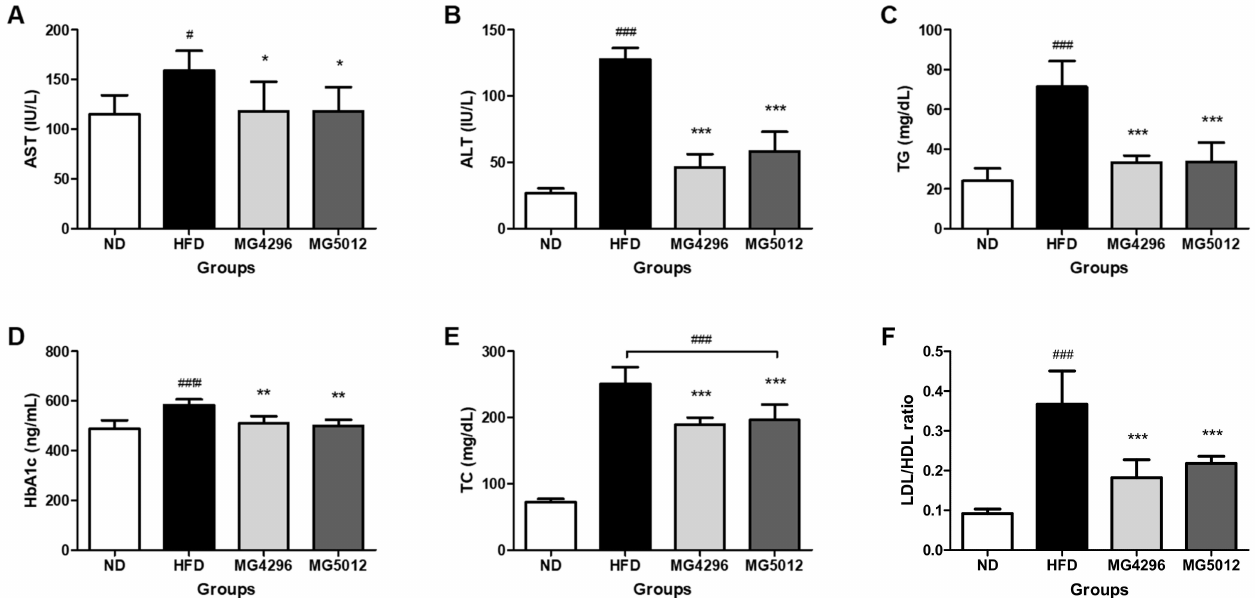
Figure 4. Biochemical profile of serum in HFD-induced T2DM mice. ( A ) AST, ( B ) ALT, ( C ) TG, ( D ) HbA1c, ( E ) TC, and ( F ) LDL/HDL ratio. Data are presented as mean ± SD ( n = 6). # p < 0.05, ### p < 0.001 vs. ND group. * p < 0.05, ** p < 0.01, *** p < 0.001 vs. HFD group. ND; normal diet, HFD; high-fat